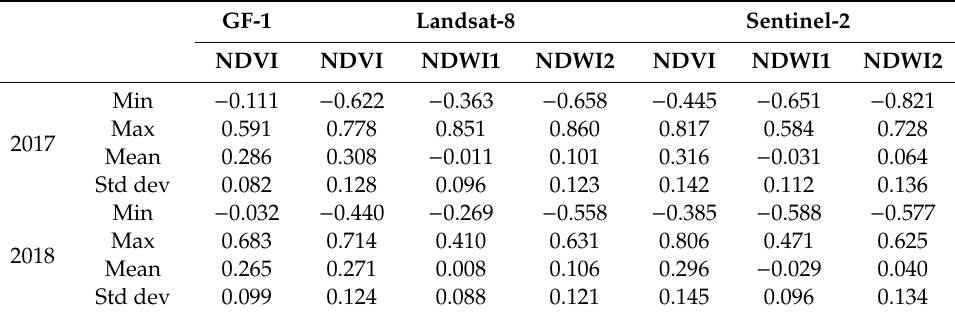
Table 4. Statistics of three optical indices in the study area.